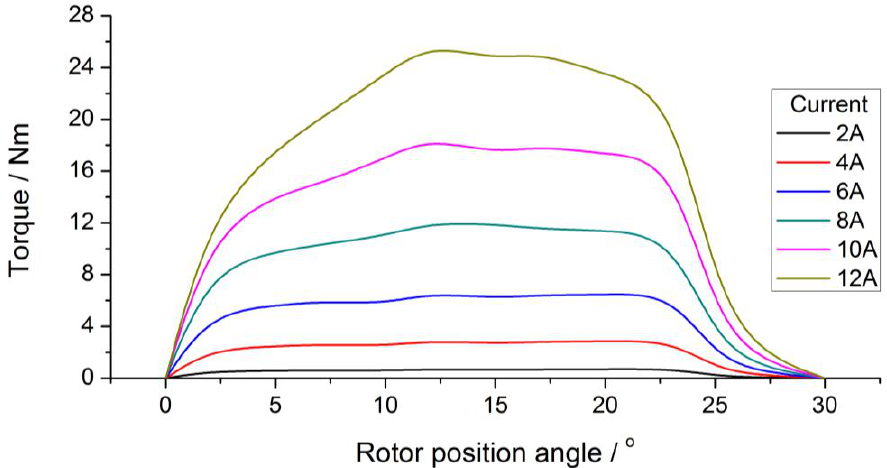
Figure 12. Curves of static torque with one phase